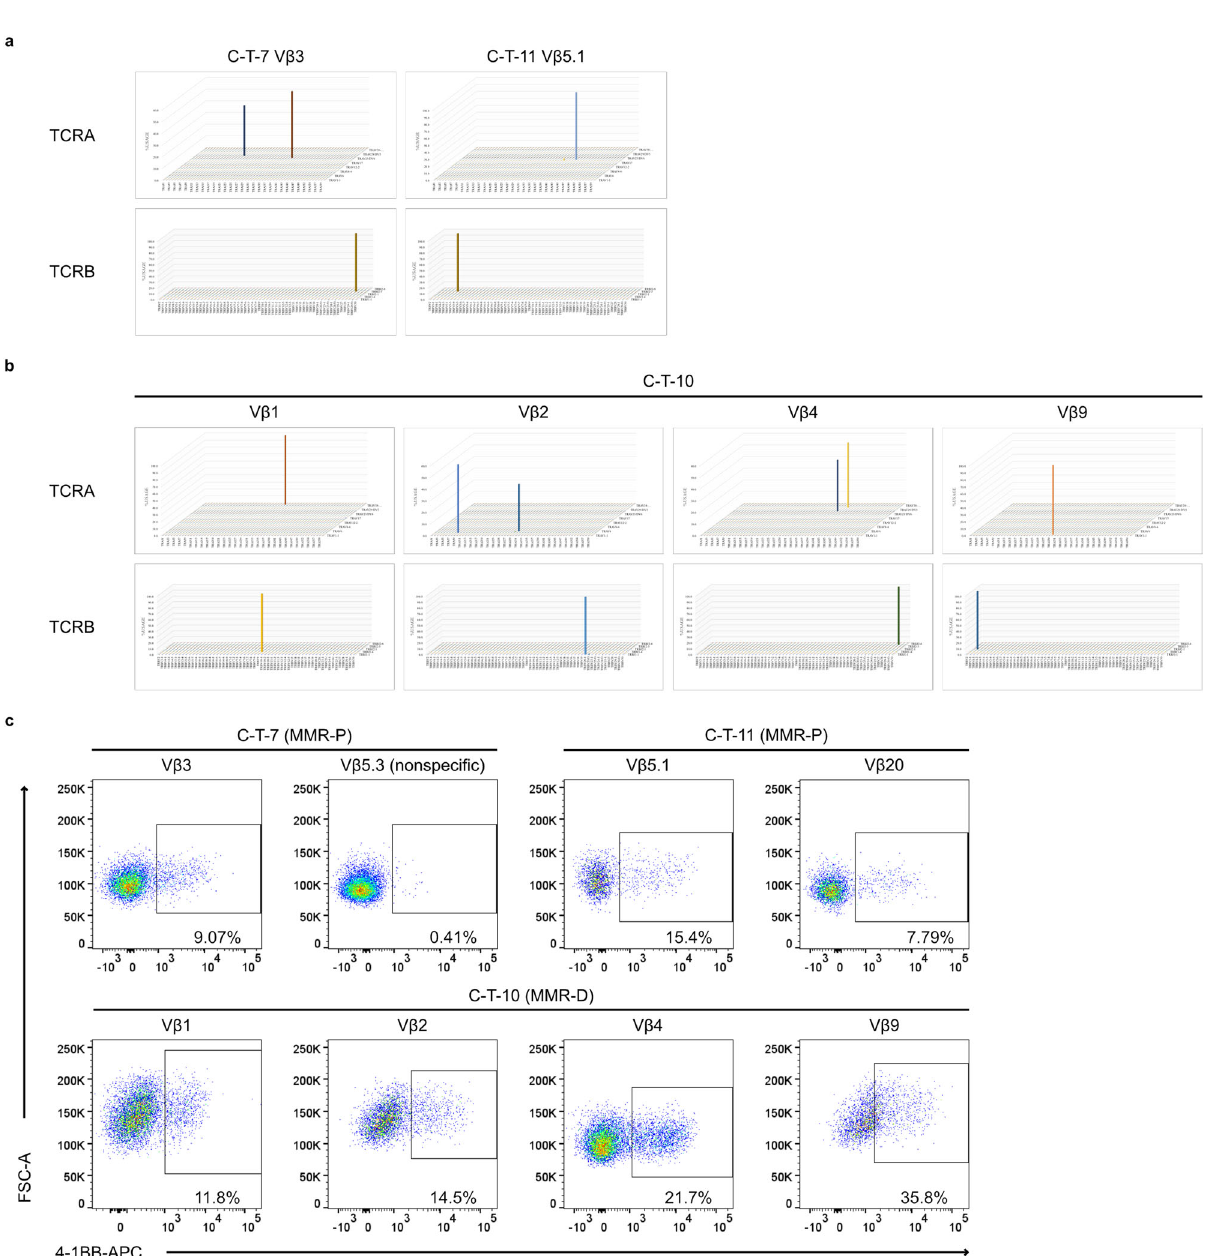
Fig. 4 TIL-iPS-T retained original TCR information and tumor speci fi city. a , b Repertoire analysis of TIL-iPS-T from MMR-P ( a ) and MMR-D ( b ). NGS was applied in the analysis. c Flow cytometry analysis regarding the tumor reactivity of TIL-iPS-T. Representative data of three independent experiments are shown. Data were gated on live